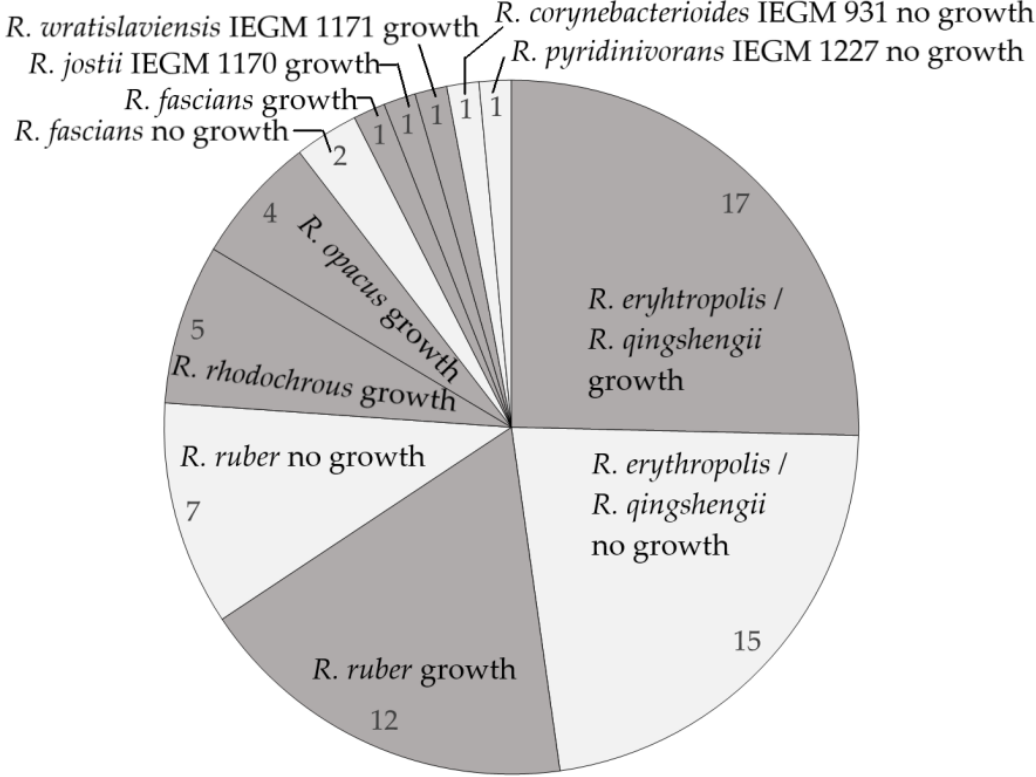
Figure 3. Degradation of naphthalene by Rhodococcus spp. Numbers show numbers of strains growing (shaded segments) or not growing (clear segments) in the presence of naphthalene used as the sole carbon and energy source.